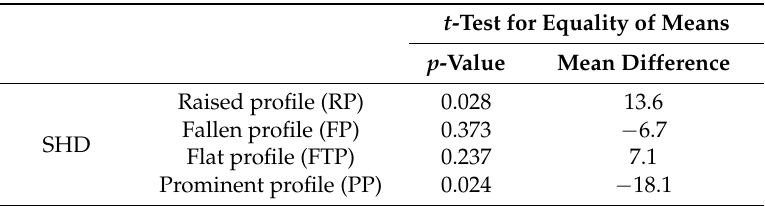
Table 4. The mean difference of SHD between types of abdominal profiles. t ‐ Test for Equality of Means